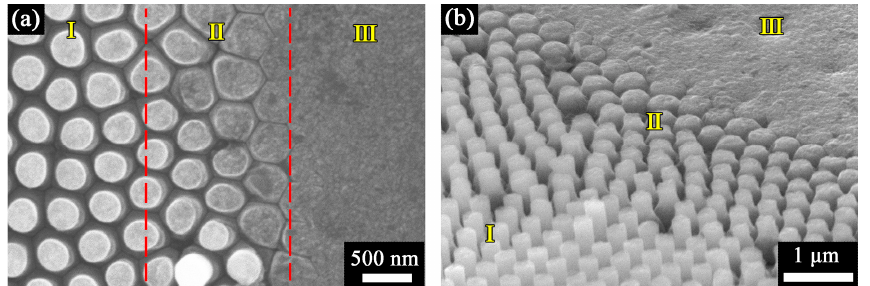
Figure 3. SEM images of diamond nanopillars at the boundary region: ( a ) top view and ( b ) tilted view. Regions I, II, and III indicate the distinct zones of templated growth of pillar array, transition zone, and plain growth of diamond, respectively.